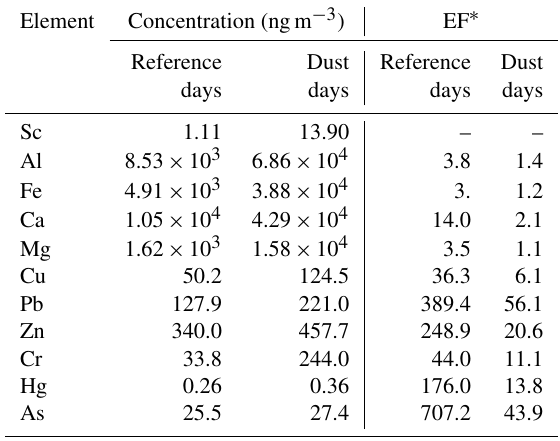
Table 3. The average concentrations and EFs of metal elements on dust and non-dust days.